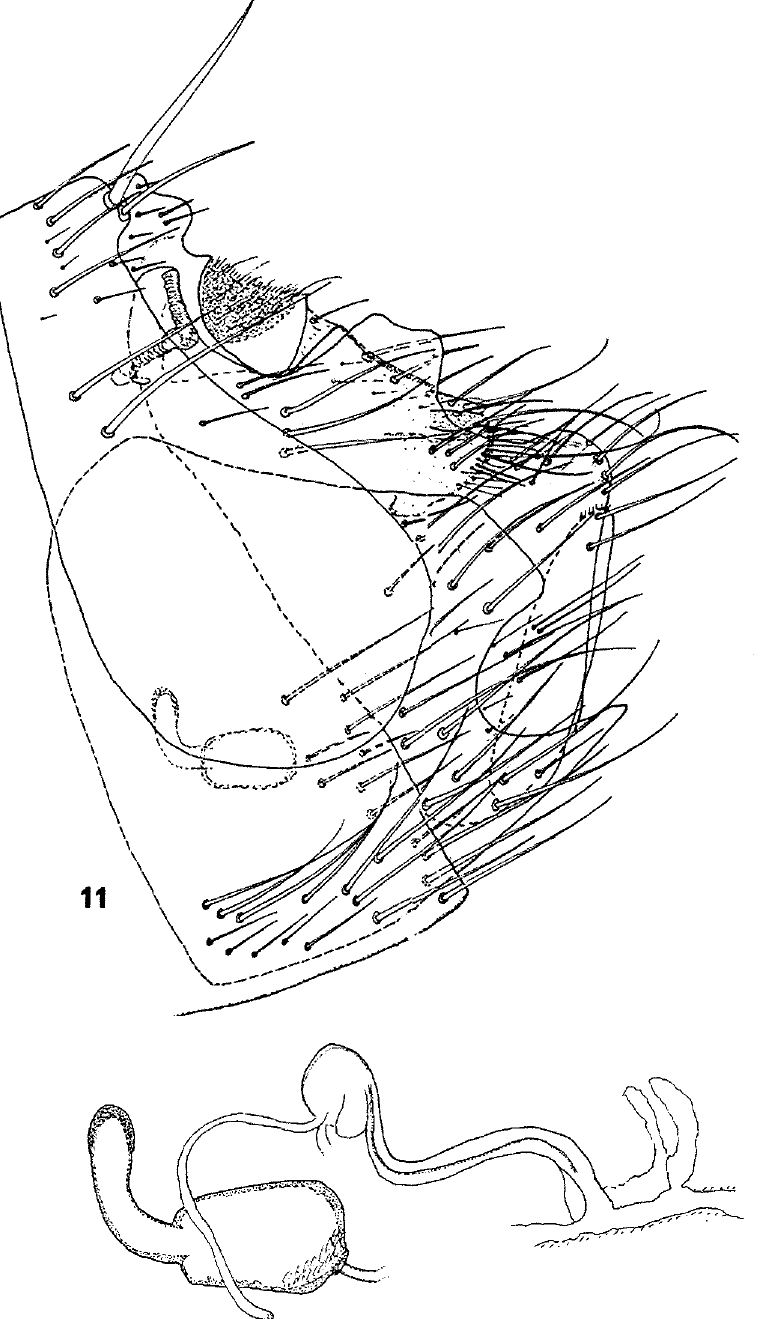
la figure 12 est à une échelle double celle de la 11. conformément à la cou- tume pour cet ordre, il n’est pas donné de dimensions chiffrées pour les